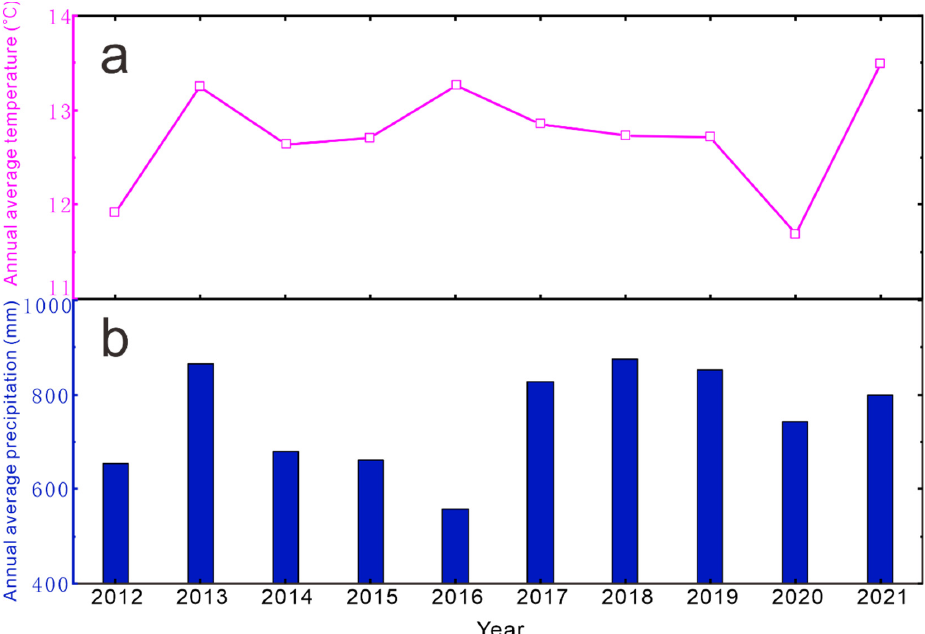
Figure 3 . Annual average temperature ( a ) and annual average precipitation ( b ) from six meteoro- logical stations (time period:2012–2021) around the study area.